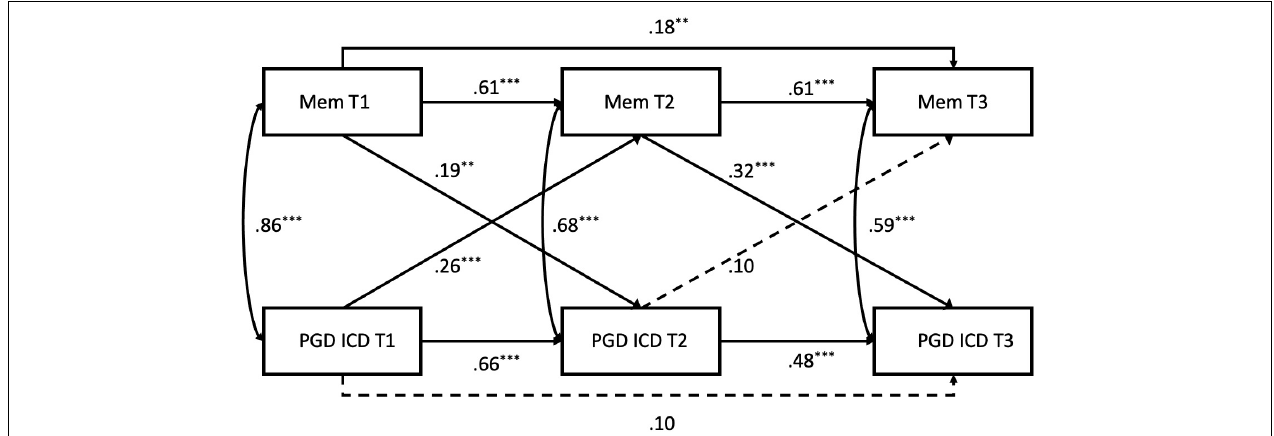
FIGURE 1 | Autoregressive cross-lagged model of PGD ICD-11 and loss-related memory characteristics. Standardised coefficients are shown. Broken lines indicate non-significant paths. MEM, The Oxford Grief Memory Characteristics Scale (OG-M); PGD ICD, Prolonged Grief Disorder according to the ICD-11 diagnostic criteria. Asterisks indicate significant associations ( ∗∗ p < 0.01, ∗∗∗ p < 0.001). χ 2 = 1.47, df = 2, p > 0.05, RMSEA = 0.00, CFI = 1.00, TLI = 1.00.